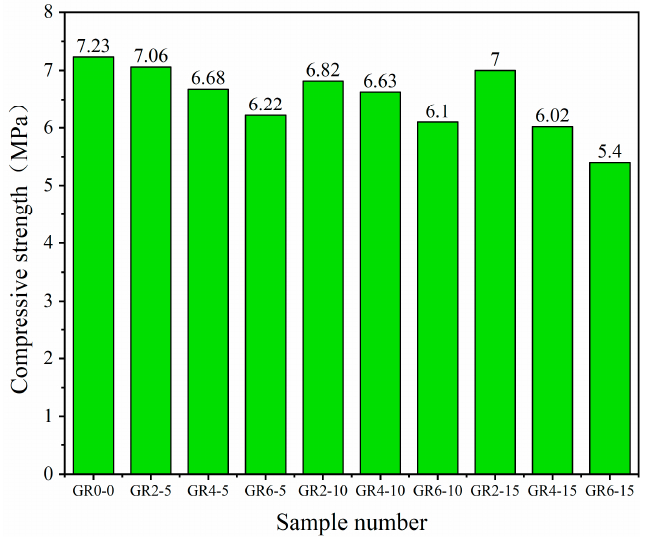
Figure 9. Compressive strength of various types of mortar on the seventh day.